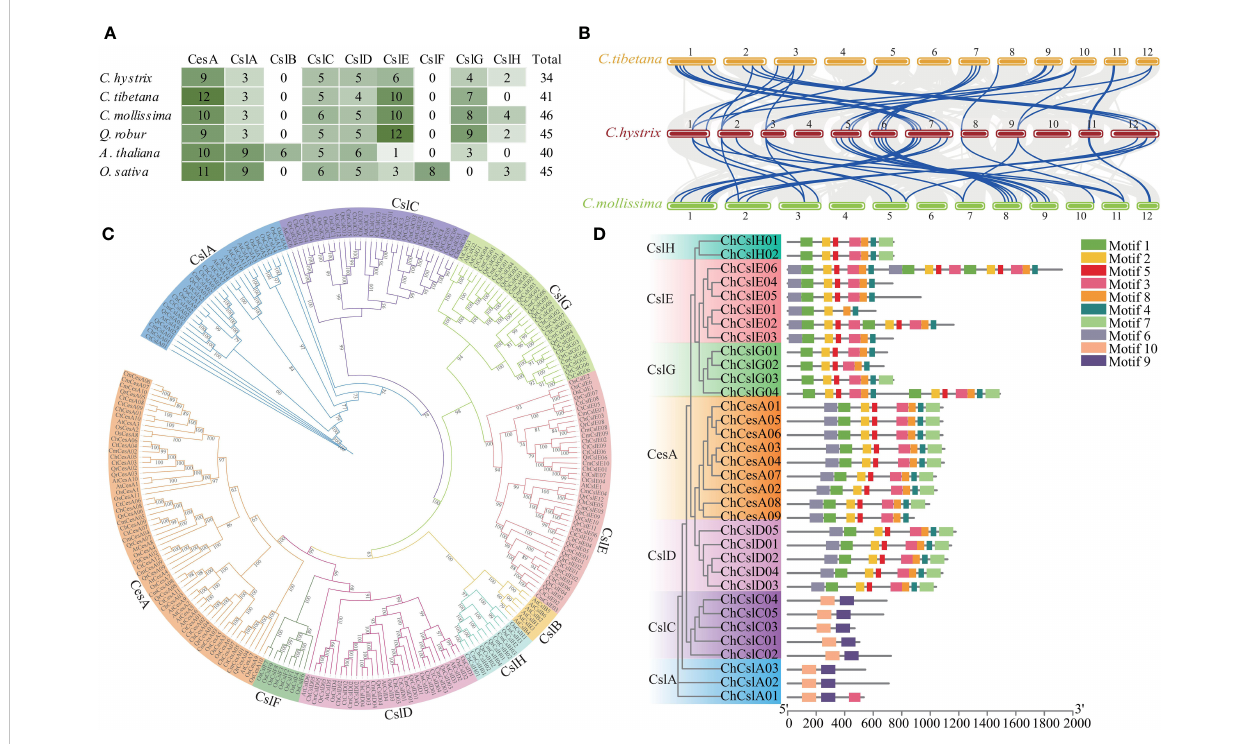
FIGURE 4 Identi fi cation and Evolution of CesA family in Fagaceae. (A) The heatmap shown a comparison of the numbers of CesA genes among four Fagaceae plants, Arabidopsis thaliana , and Oryza sativa . (B) Synteny analysis of CesA genes between C hystrix , C tibetana , and C mollissima . The blue lines highlight the syntenic CesA gene pairs. (C) Phylogenetic tree of CesA gene families in four Fagaceae plants, A thaliana , and O. sativa . (D) Phylogenetic relationships and architecture of the conserved protein motifs in 34 CesA genes from C hystrix